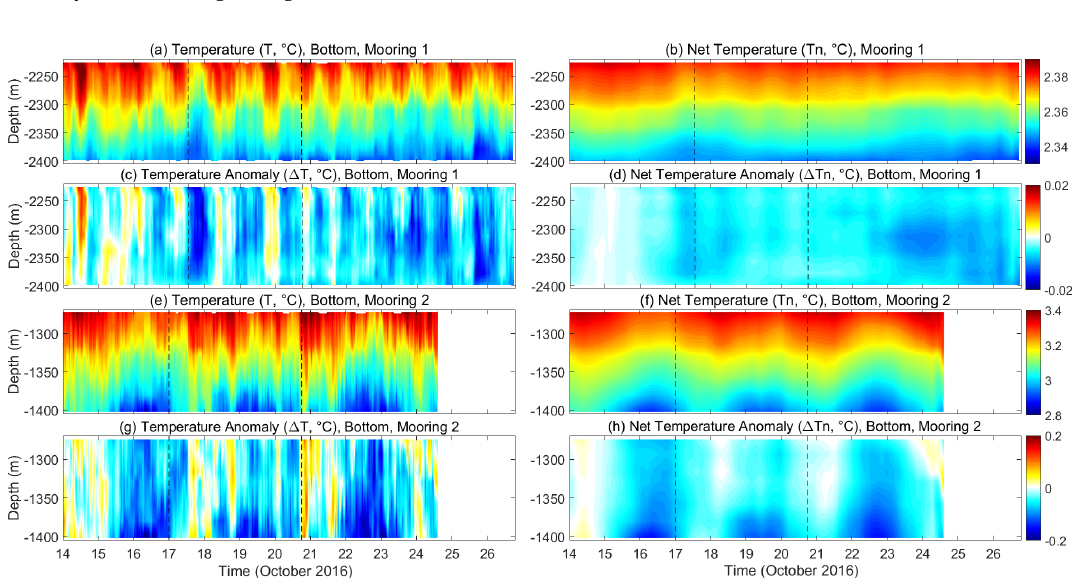
Figure A5. Temperature, net temperature, and their anomaly during Sarika and Haima at the bottom of Mooring 1 ( a – d ) and Mooring 2 ( e – h ). Net temperature is the one inertial period running mean of temperature response. The temperature anomaly was calculated as the temperature minus the average temperature over the period UTC 00:00 on 13 October to UTC 00:00 on 15 October. Dashed lines represent the time that Sarika and Haima were closest to the